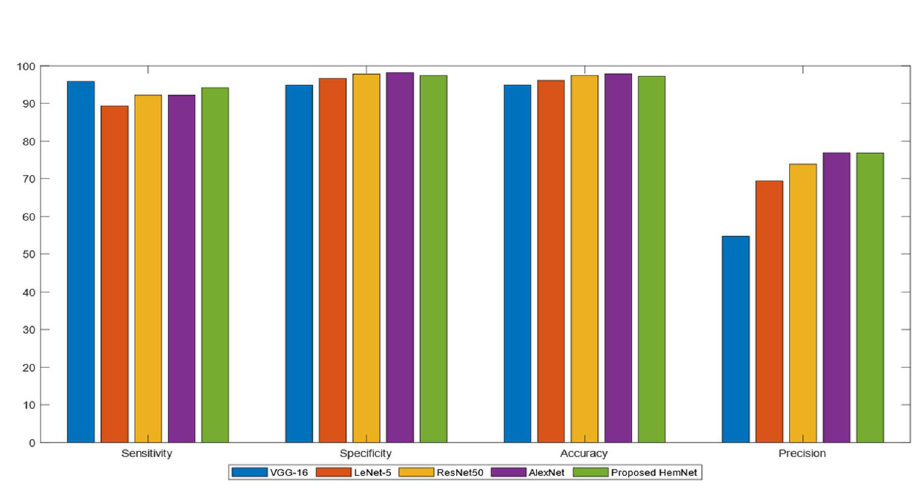
Figure 5. Comparison of deep models with proposed HemNet Network on DIARETDB1 Dataset.